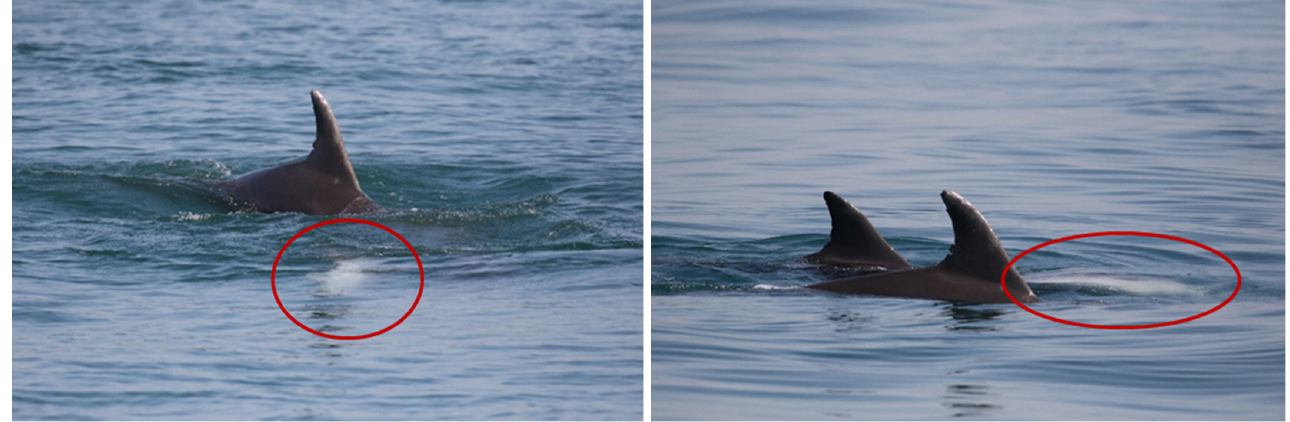
Figure 9. Left picture: UNIRM_025 passing over the carcass; right picture: UNIRM_025 ( right dolphin) swimming close to UNIRM_142 ( left dolphin). Red circles highlight the carcass. A total of 233 min in 24.wav files were collected, identifying 733 click trains, 4 burst